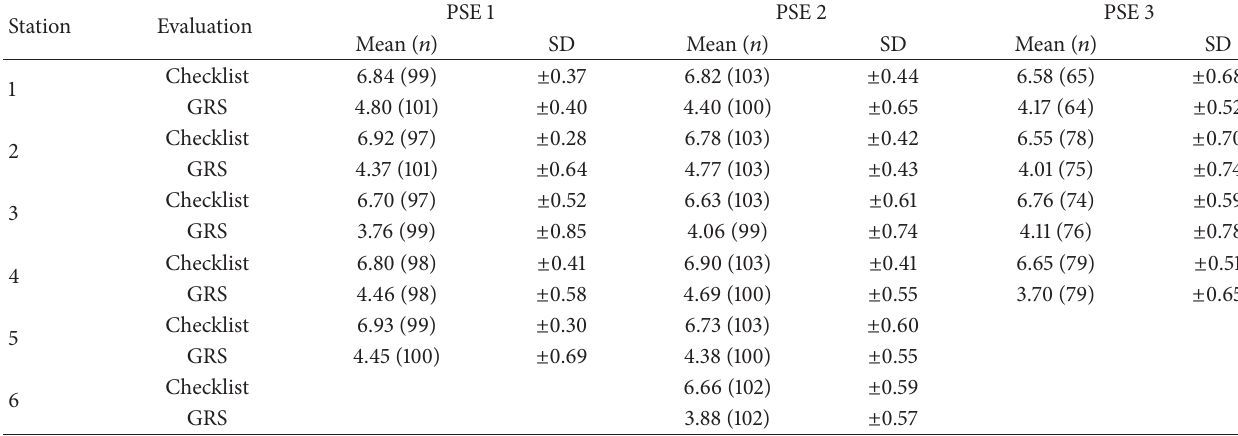
Table 3: Mean and standard deviation for checklist (/7) and GRS (/5) scores per station for each PSE.